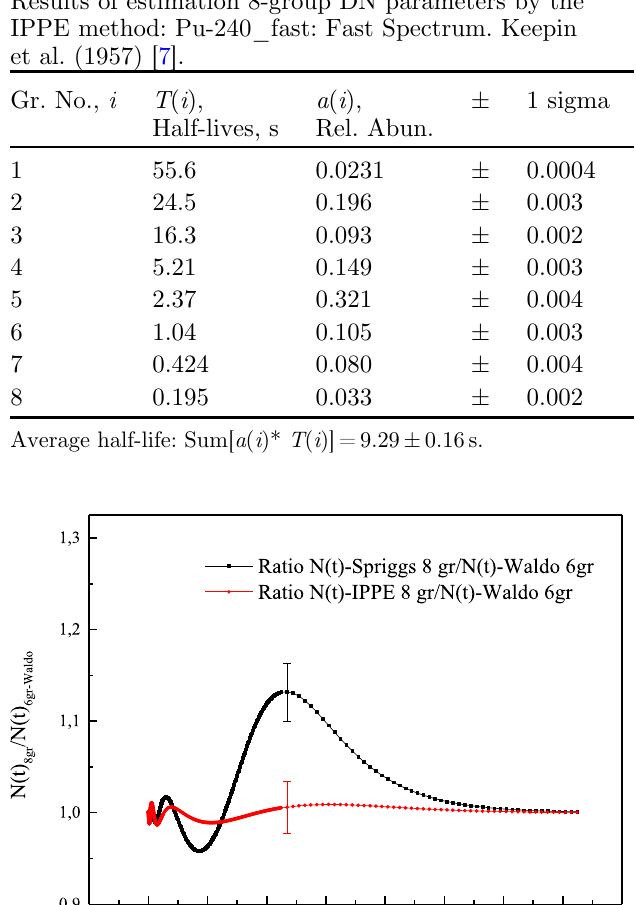
Table 2. The 8-group DN parameters from processing of the DN decay curve generated from the 6-group DN parameters from fi ssion of 240 Pu by fast neutrons (the IPPE expansion method [6]).